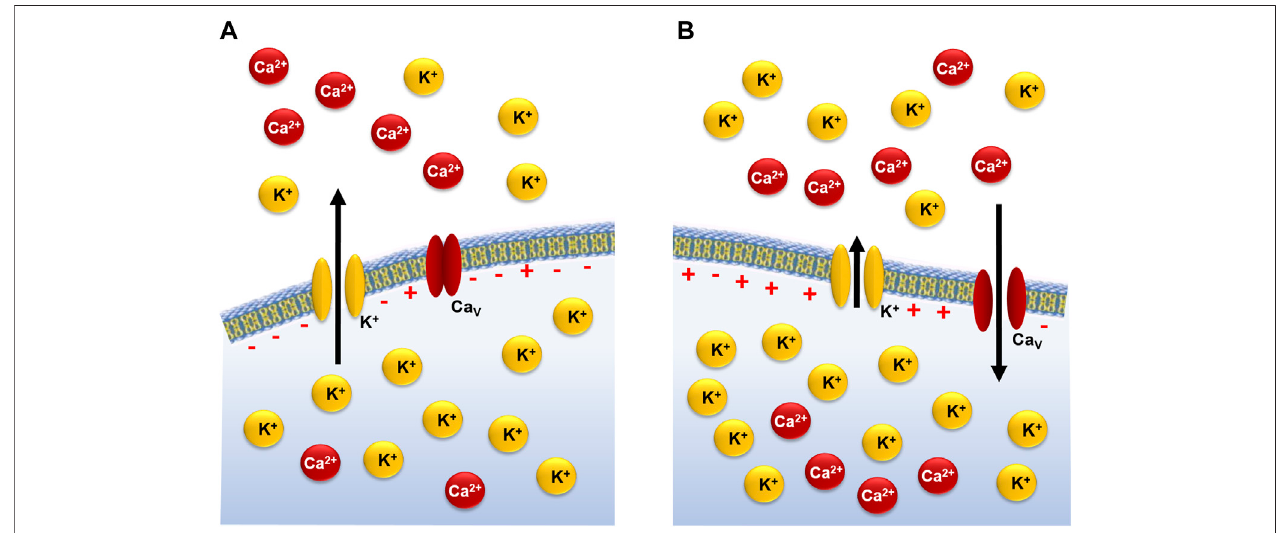
FIGURE 1 | Electromechanical coupling of cavernous smooth muscle contraction during rest (A) and after increase in [K + ] e (B) .